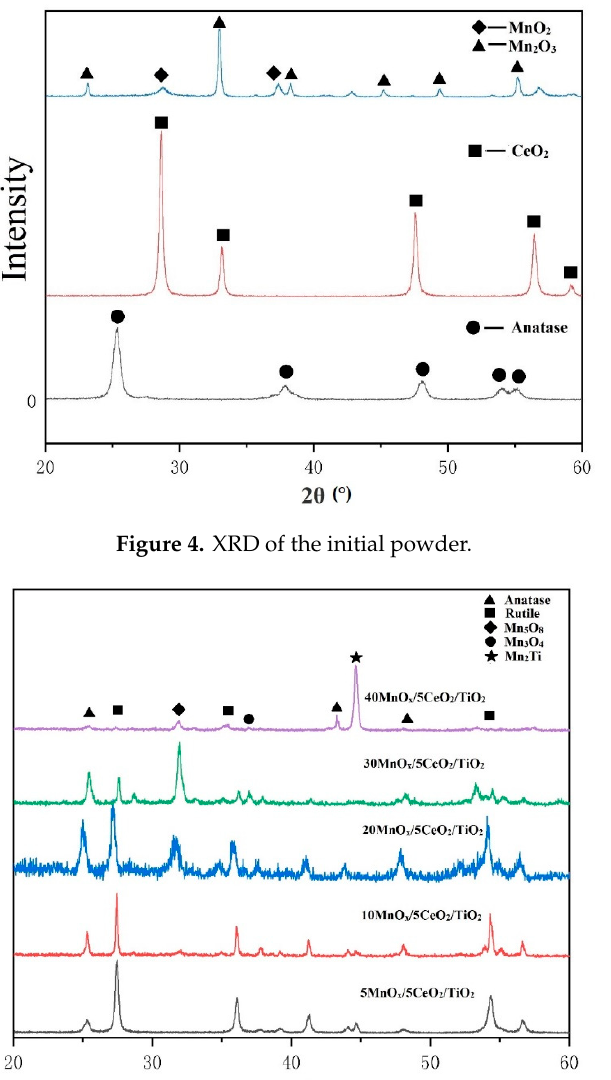
Figure 5. XRD pattern of plasma sprayed coating on steel plate with different composition.